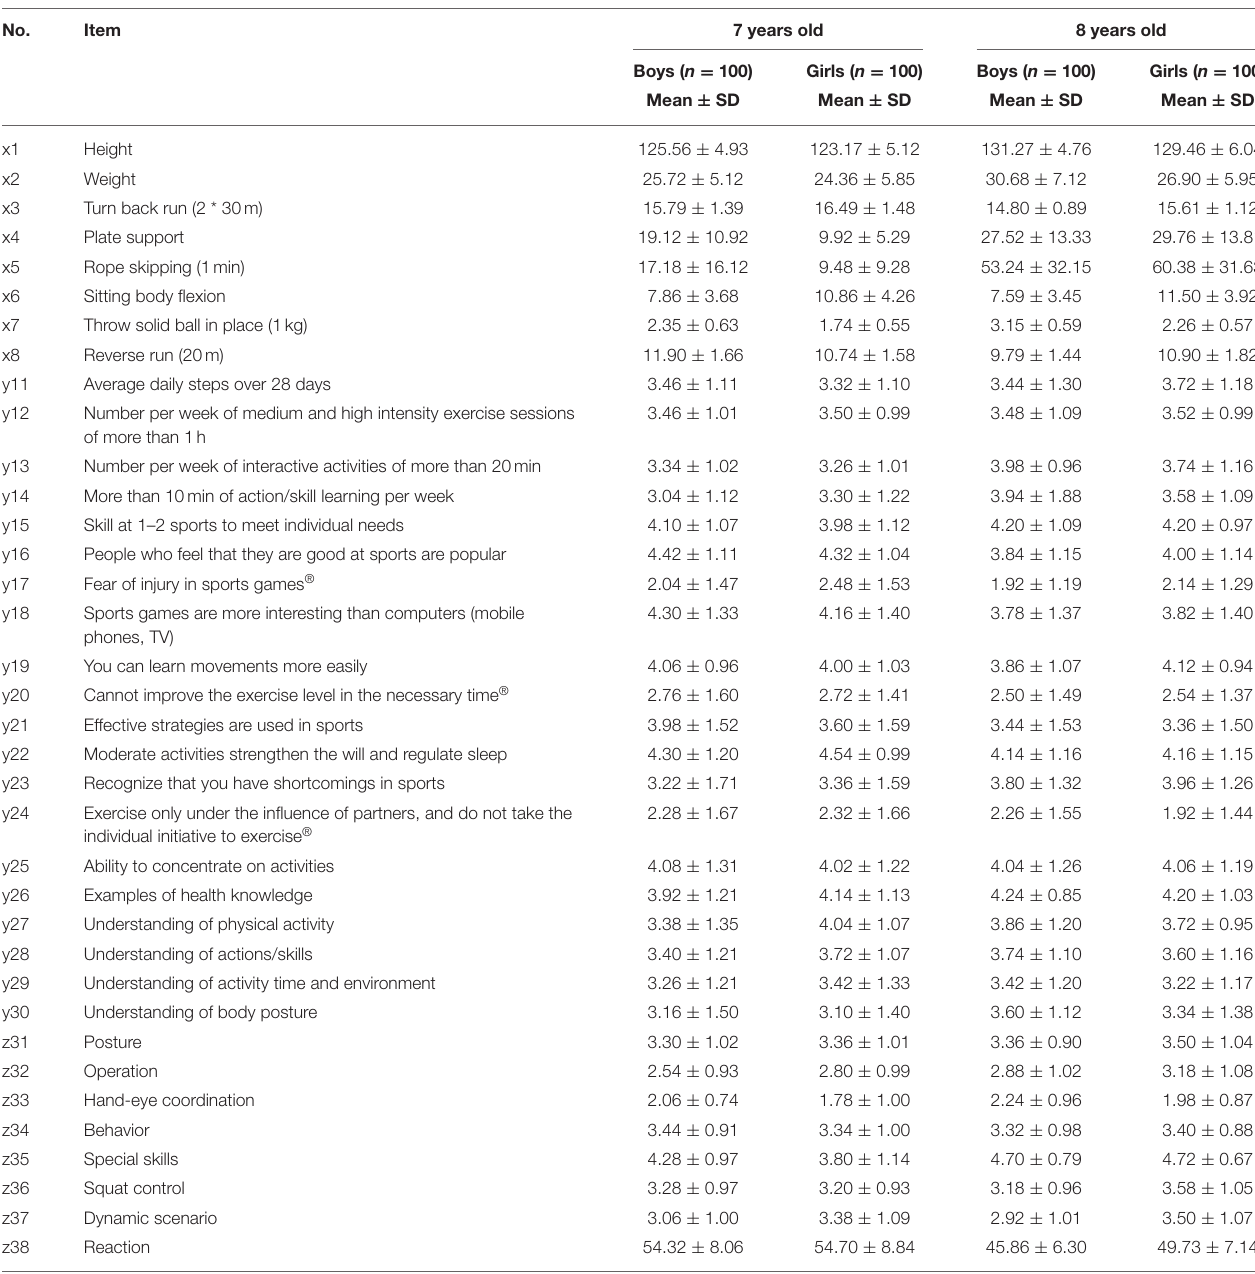
TABLE 3 | Test results categorized by the age and